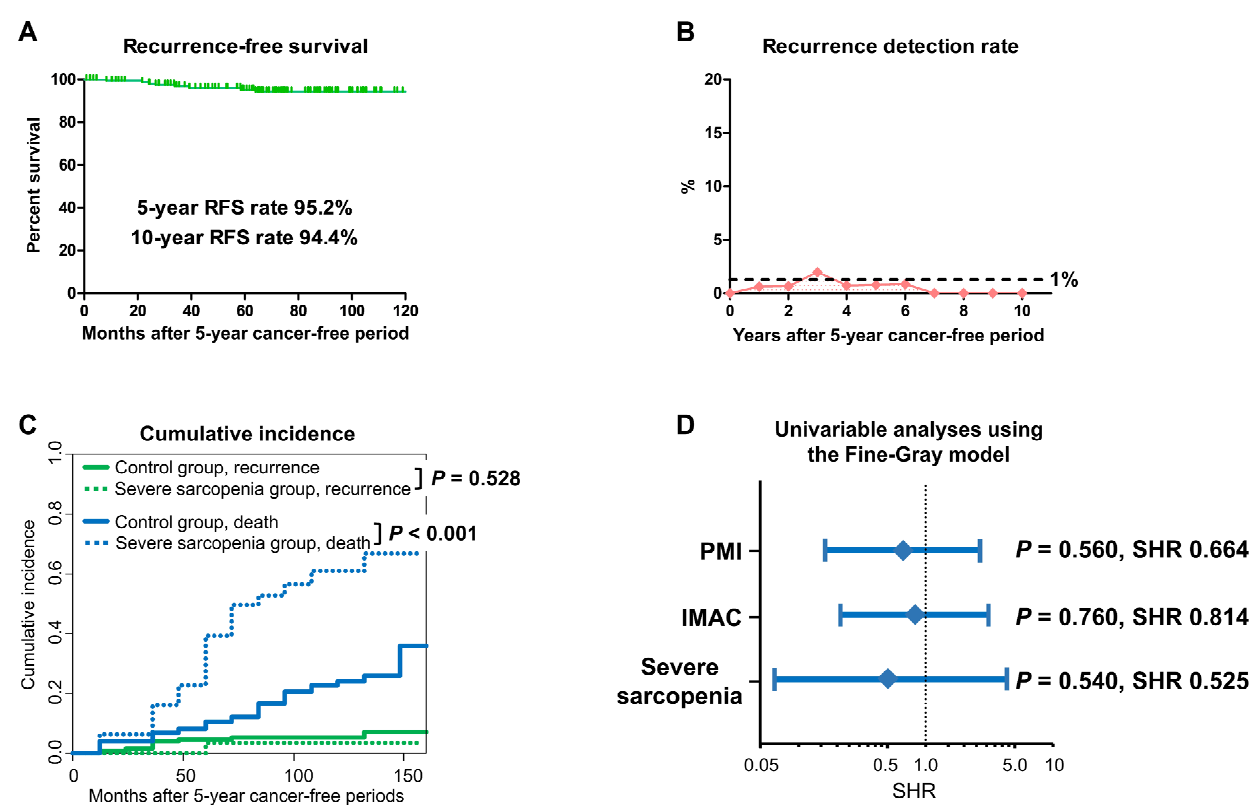
Figure 2. Recurrence-free survival (RFS) and recurrence detection rate. RFS in all included patients after a 5-year cancer-free period was evaluated using the Kaplan–Meier method ( A ). Recurrence detection rate ([number of patients with recurrence/number of patients with surveillance during a certain period] × 100) was evaluated ( B ). The Gray test was performed to compare cumulative incidences between the control and severe sarcopenia groups ( C ). Univariable analyses were performed to assess the impact of severe sarcopenia on recurrence, adjusting for the competing risk of death using the Fine-Gray subdistribution hazards model ( D ). PMI, psoas muscle index. IMAC, intramuscular adipose tissue content. SHR, subdistribution hazard ratio.